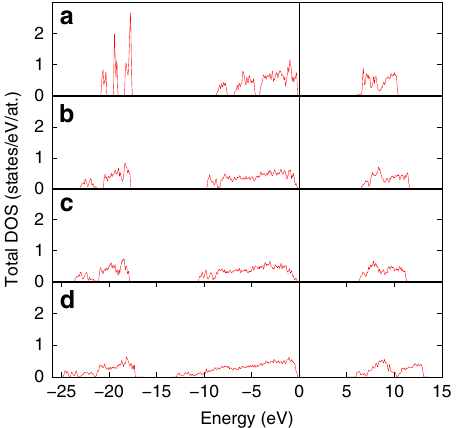
Fig. 5 Calculated total electronic density of states (DOS) of different phases of hurlbutite, CaP 2 Be 2 O 8 . a Hurlbutite at 2.9 GPa; b hurlbutite-II at 66.9 GPa; c hurlbutite-III at 68.7 GPa; d hurlbutite-IV at 79.6 GPa. Energy